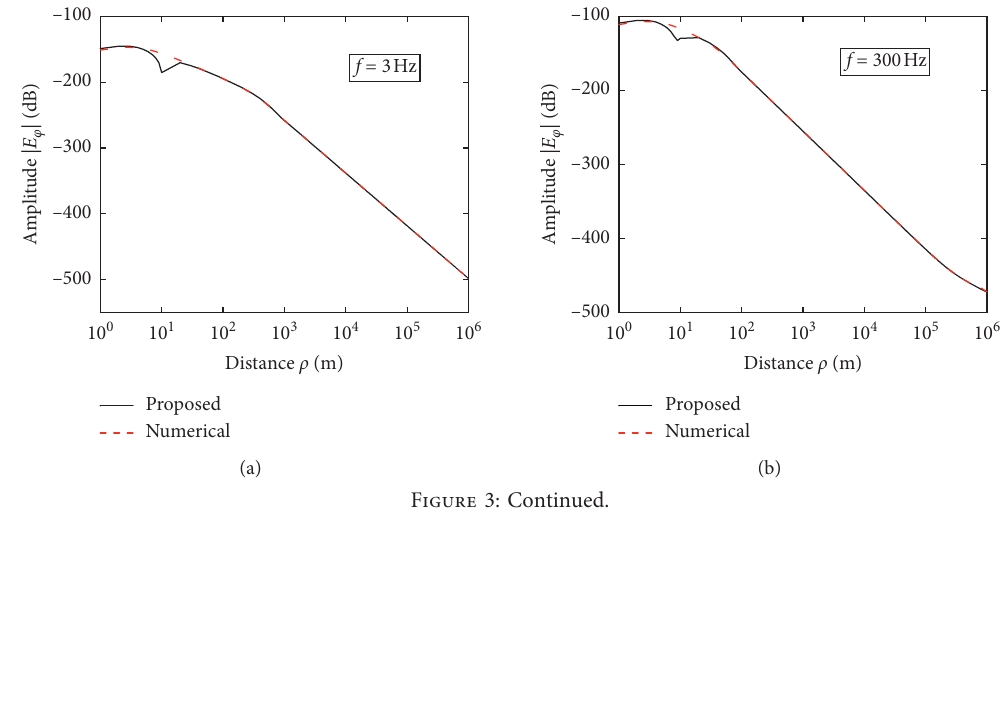
Figure 2: Amplitudes and phase angles of field component H solutions. (a, c) f � 3Hz. (b, d) f �